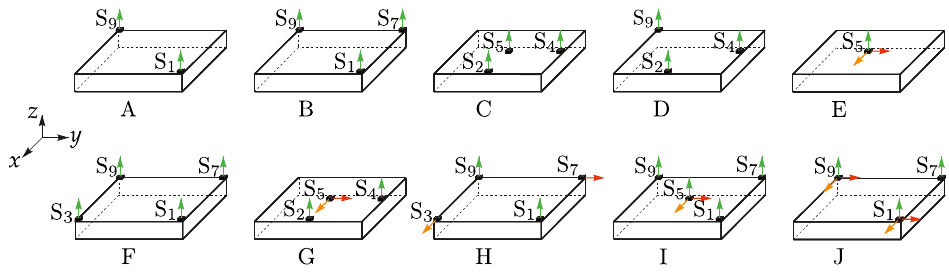
Figure 5. Sensor settings for 2, 3, 4, 6 and 7 acceleration measurements per platform.